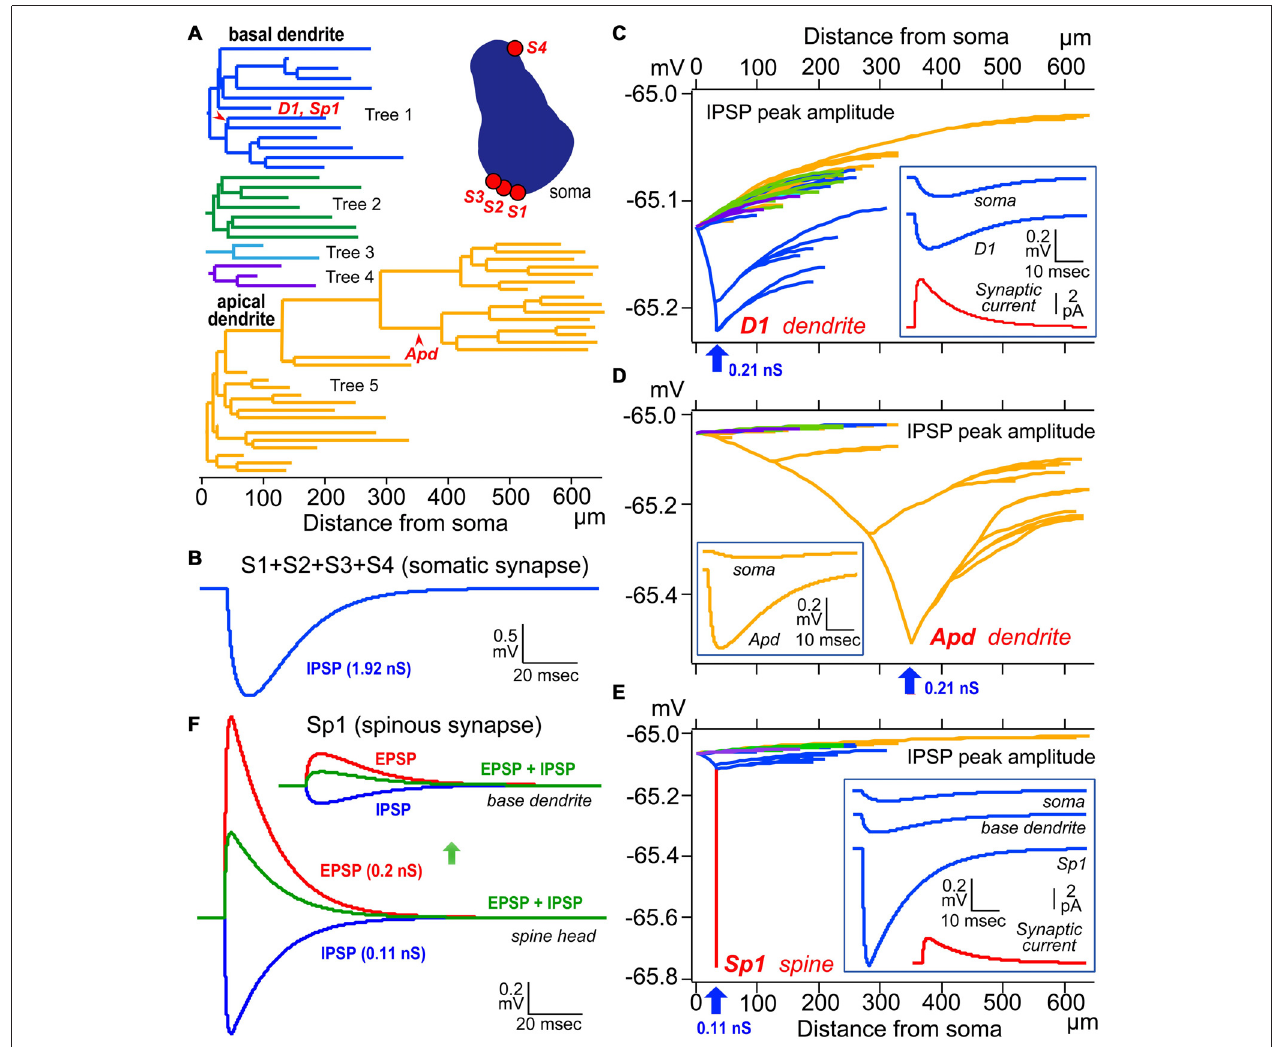
FIGURE 6 | Simulation analysis of inhibitory postsynaptic potential (IPSP) on dendritic spine, shaft and somatic IPSCs. (A) Left, color-coded dendrogram with inhibitory synaptic current injection sites on the dendrites (red arrowheads). Right, a cross-section of the cell body of the model pyramidal cells with four somatic synaptic contacts. (B) The simulated IPSP wave-form at the soma induced by injection of a total of 1.92 nS inhibitory conductance summed across the somatic synapses S1–S4. (C) Peak dendro-somatic potential changes (color-coded as in A ) induced by an inhibitory conductance of 0.21 nS (inset, red trace, simulated synaptic current) injected into the shaft of a basal dendritic branch (D1, blue arrow; corresponding to D1 in A ). The simulated IPSP wave-forms at the injection site (D1) and soma are shown in the inset (blue traces). Resting potential is − 65 mV. (D) Peak dendro-somatic potential changes induced by an inhibitory conductance of 0.21 nS (simulated IPSC is quite similar to the red trace shown in inset in C , red trace) injected into the shaft of an apical dendritic branch (Apd, blue arrow; corresponding to Apd in A ). The simulated IPSP wave-forms at the injection site (Apd) and soma are shown in the inset (yellow traces). Resting potential is − 65 mV. (E) Peak membrane potential changes over the somato-dendritic membrane induced by an inhibitory conductance of 0.11 nS injected at the spine head Sp1 (blue arrow, corresponding to Sp1 in A ; simulated IPSC shown in red trace in inset). Peak inhibitory potential in the spine is indicated in red. The simulated IPSP wave-forms at the injection site (Sp1), base of dendrite and soma are shown in inset (blue traces). (F) Reduction (green) of the excitatory postsynaptic potential (EPSP) resulting from the injection of an EPSC waveform (with peak conductance of 0.2 nS; red) at the Sp1 spine head (lower superimposed traces) and base dendrite locus (upper superimposed traces)) by an IPSC (0.11 nS; blue) injected at the same site and time. Adapted from Kubota et al. (2015). The simulations were made with “NEURON” (Hines and Carnevale, 1997) and the CS56 pyramidal cell model neuron publicly available at ModelDB (Accession no: 183424; http://senselab.med.yale.edu/ModelDB/showModel.cshtml?model=183424. The datasets are also available at